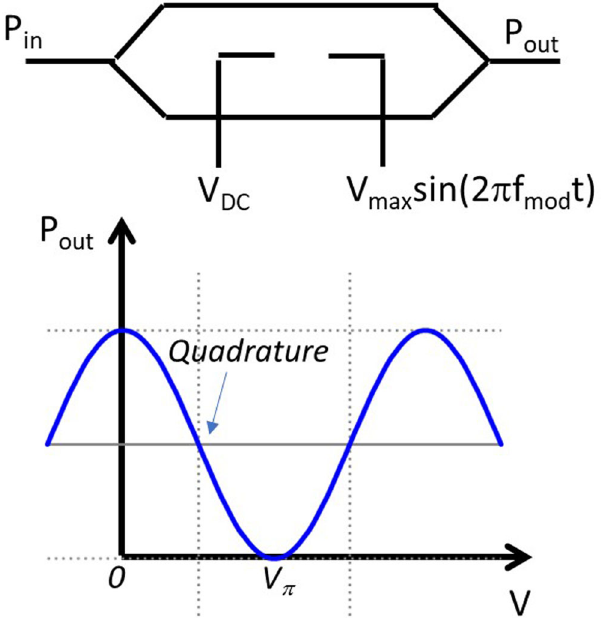
Fig. 10 Layout of the Mach Zehnder modulator. The DC voltage ( V DC ) sets the quadrature point of the modulator at V π /2 so that, if the maximum voltage of the RF modulation signal ( V max ) is small, the output light power ( P out ) responds linearly to the RF modulation signal. Notice that the overall voltage applied to the modulator is given by V DC + V max sin ( 2 π f mod t ).